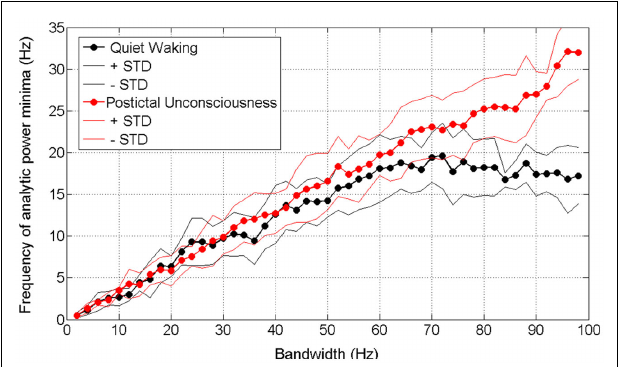
FIGURE 5 | Rice curves for waking and postictally unconscious ECoG data. Analytic power minima with threshold set at 30% (as in Figure 4 ). Center frequency of all passbands is 50Hz – thus a bandwidth of 40Hz on the horizontal axis represents a passband of 30–70Hz and a bandwidth of 60Hz represents a passband of 20–80Hz. Circles represent mean values for all four subjects.